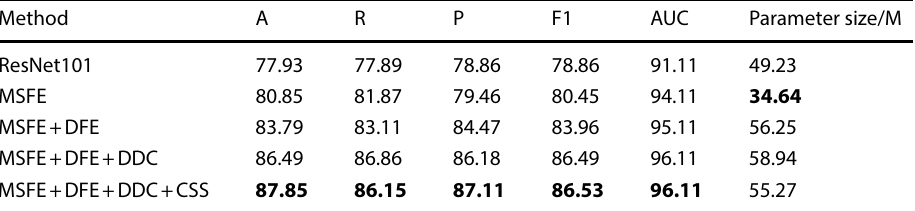
The bold value denotes the best